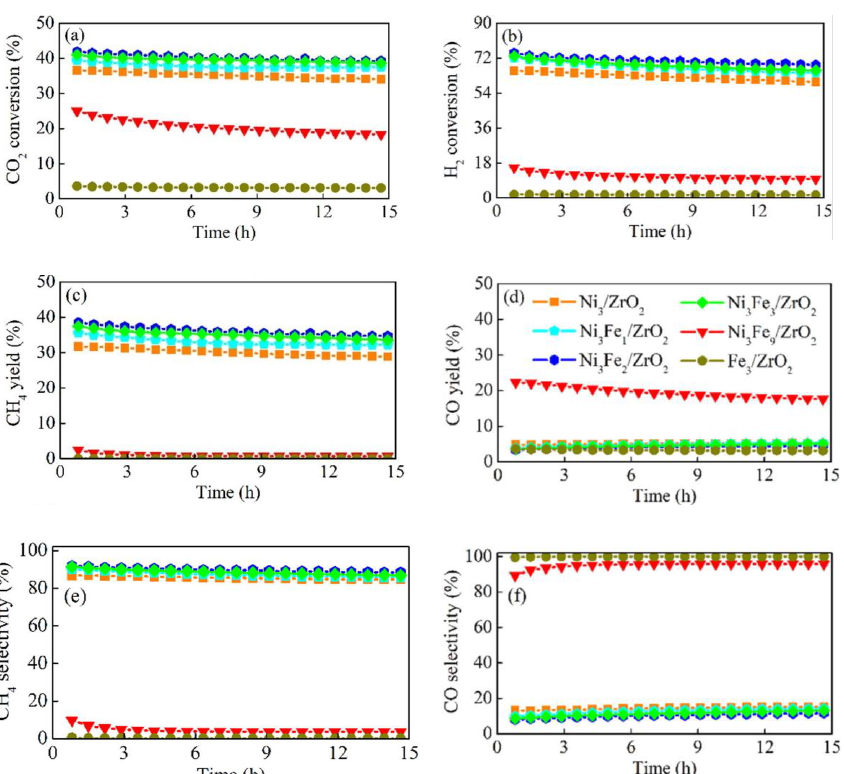
Figure 5. Conversions of ( a ) CO 2 and ( b ) H 2 , yields of ( c ) CH 4 and ( d ) CO, and selectivities of ( e ) CH 4 and ( f ) CO on ZrO 2 -supported catalysts plotted versus time on stream for reaction of CO 2 and H 2 (5 mL/min CO 2 + 10 mL/min H 2 + 25 mL/min Ar) at 673 K. Reproduced with permission from [65]. Copyright: Elsevier, Amsterdam, The Netherlands, 2019.